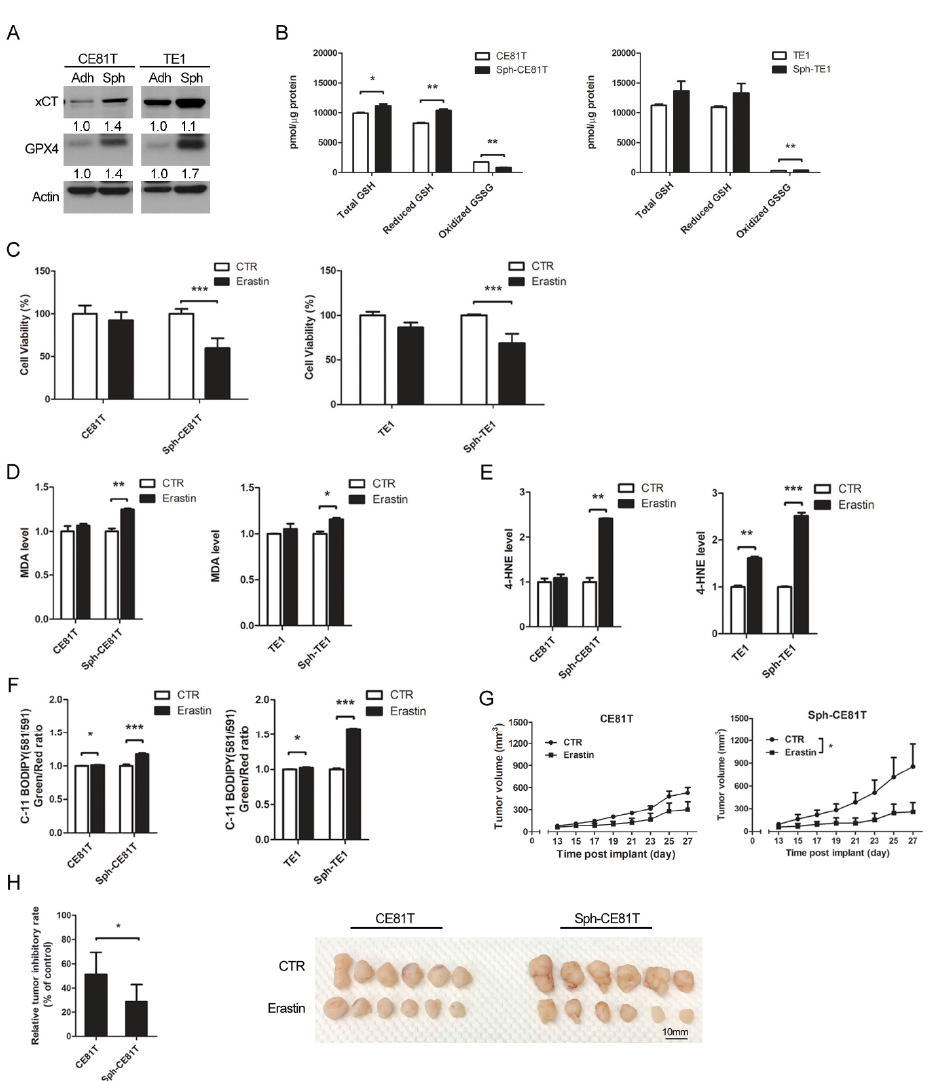
Figure 3. Inhibition of xCT induced more ferroptosis in esophageal cancer cells in spheroid culture. ( A ) Western blot analysis with quantification of xCT and GPX4 in CE81T and TE1 cells in spheroid or adherent culture. ( B ) GSH/GSSH ratio of cells in different cultures. ( C ) Viability of cells in different cultures with or without erastin (20 μ M) treatment. ( D ) MDA production of cells in different cultures with or without erastin (20 μ M). ( E ) 4-HNE of cells in different cultures with or without erastin (20 μ M) treatment. ( F ) Quantification of C-11 BODIPY staining of cells in different cultures with or without erastin (20 μ M) treatment. ( G ) Tumor volume and ( H ) weight measurement with photography after subcutaneous injection of 10 6 CE81T cells in NOD/SCID mice followed by erastin treatment (40 mg/kg, intraperitoneal injection, twice every other day for 2 weeks). * p < 0.05, ** p < 0.01, *** p < 0.001. p value of B, G, H were calculated by two-way ANOVA. p value of C, D, E, F were calculated by Student’s t -test.